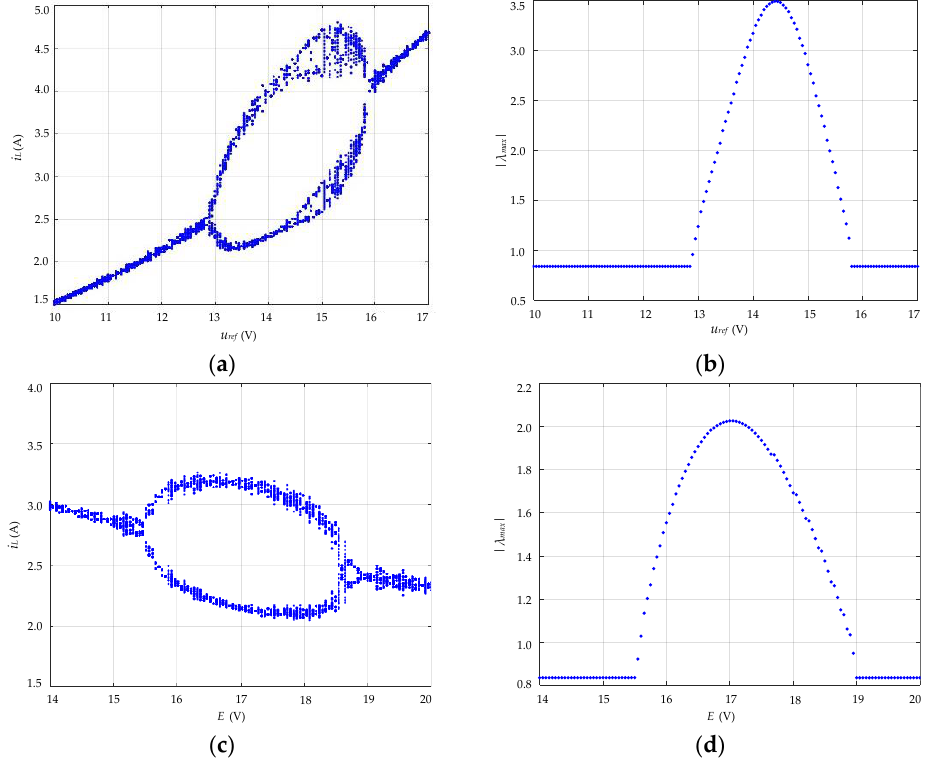
Figure 4. Bifurcation diagrams and maximum Jacobi matrix eigenvalues verification of the system with different sensitive parameters: ( a ) Bifurcation diagram with u ref as the sensitive parameter; ( b ) maximum Jacobi matrix eigenvalues with u ref as the sensitive parameter; ( c ) bifurcation diagram with E as the sensitive parameter; ( d ) maximum Jacobi matrix eigenvalues with E as the sensitive parameter.